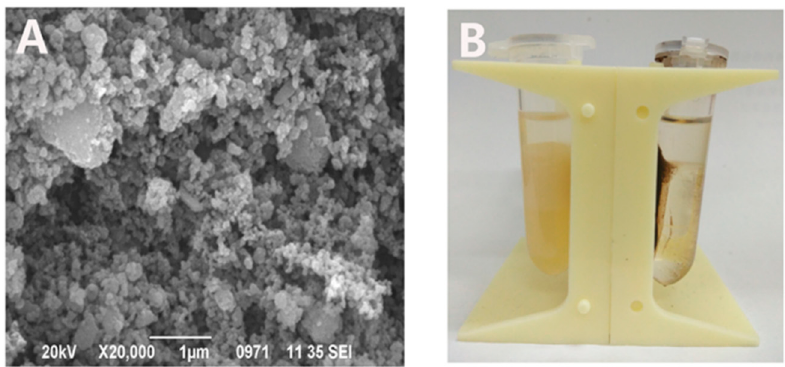
Figure 1. ( A ) Scanning electron microscopy picture of Fe 3 O 4 /SiO 2 particles. ( B ). Separation of immobilized PLD a2 from reaction products using a magnet.